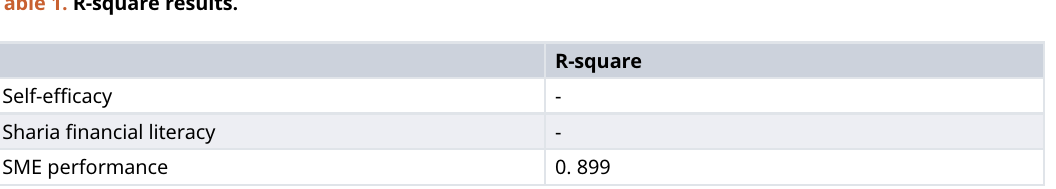
Source: Output partial least squares structural equation modeling